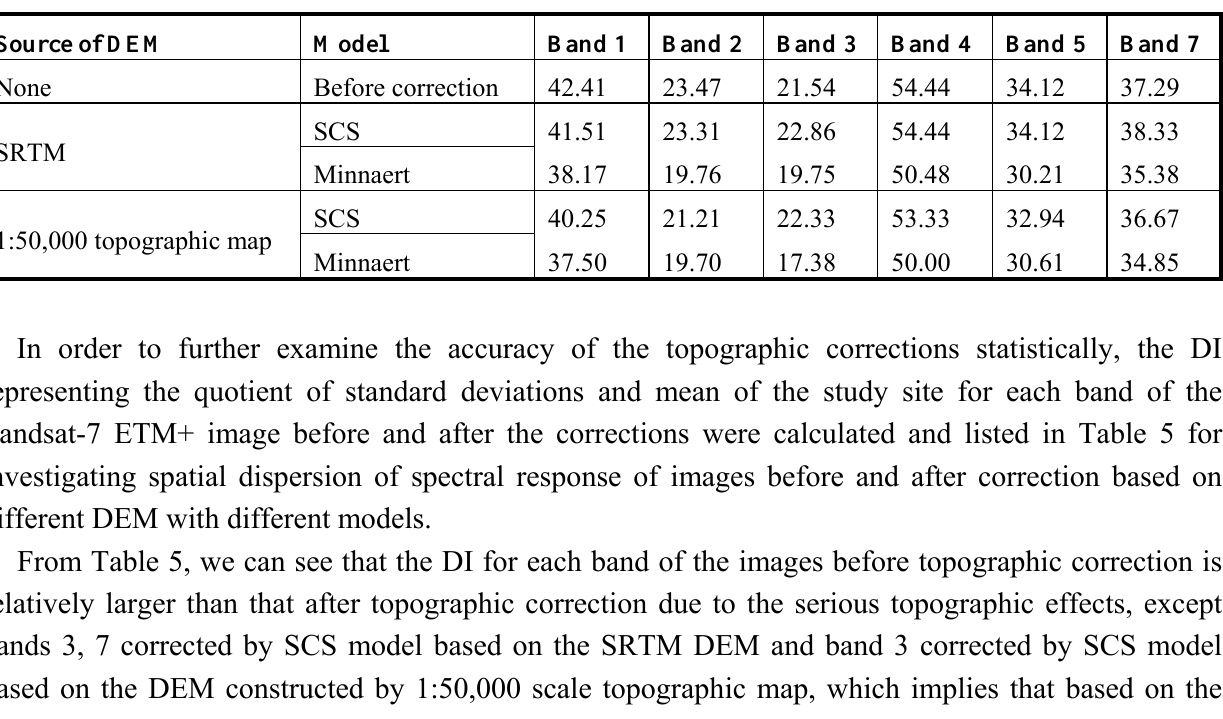
Table 5. Quotient comparison of SD and Mean for each band of the Landsat-7 ETM+ image before and after topographic correction (unit: